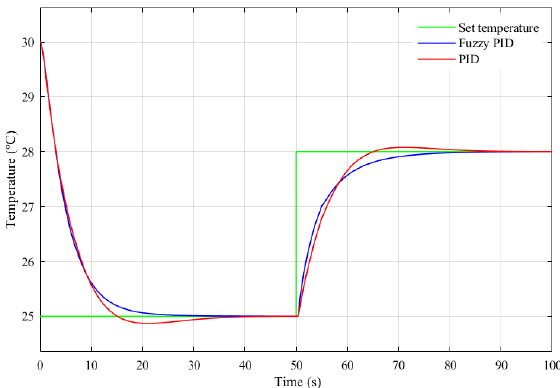
Figure 13. Simulation comparison of control effects. Table 1. Table of the fuzzy control rules ( ∆𝐾 𝑝 / ∆𝐾 𝑖 / ∆𝐾 𝑑 ).